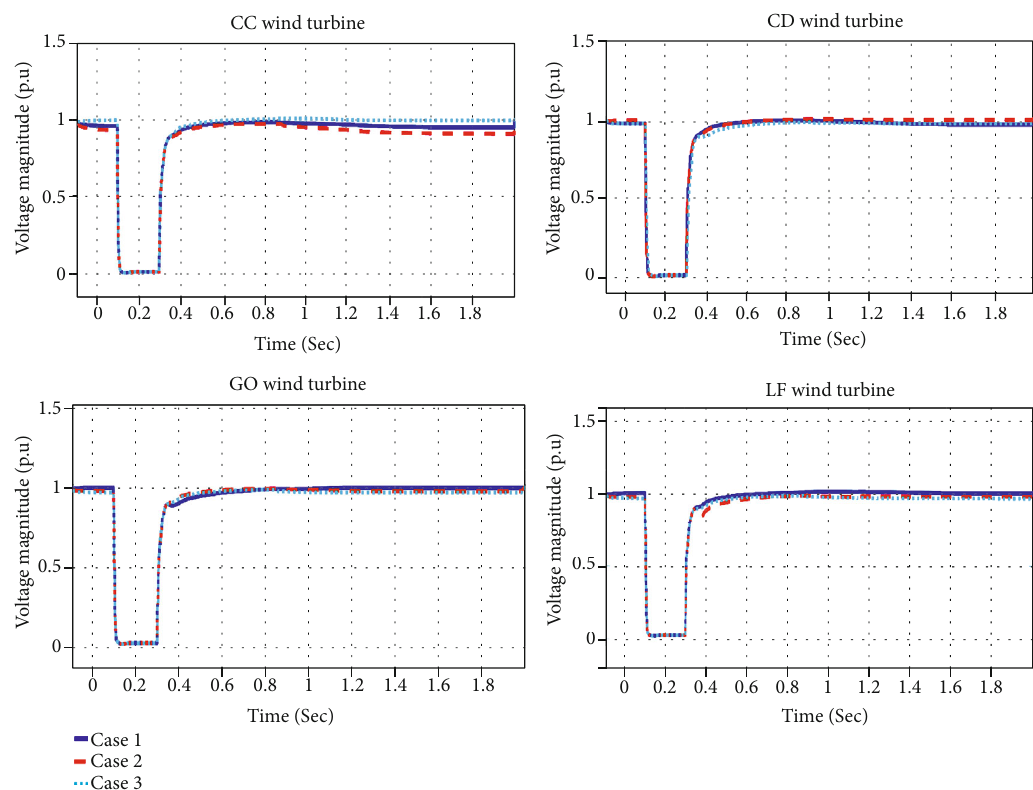
Figure 15: Voltage magnitudes from wind turbine module for four dispatch strategies. This fi gure is reproduced from Shezan et al.